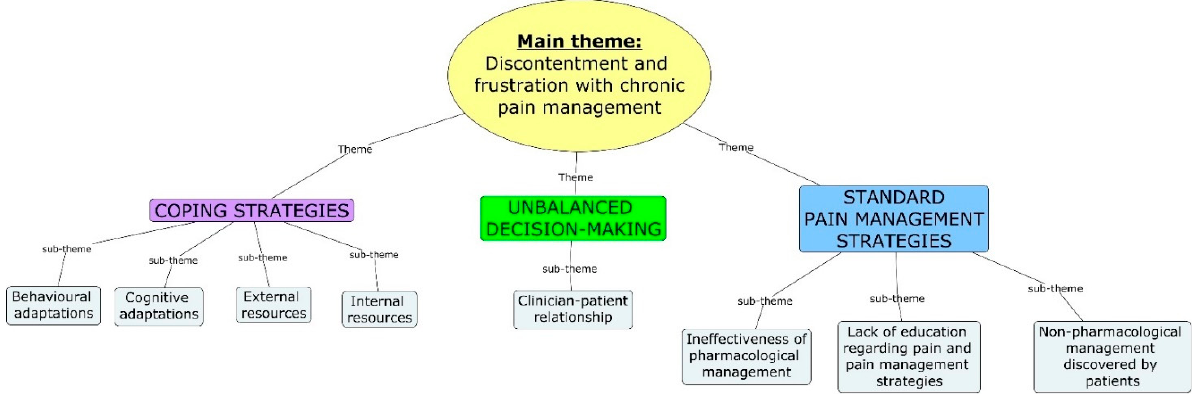
Figure 1. Main theme, themes and